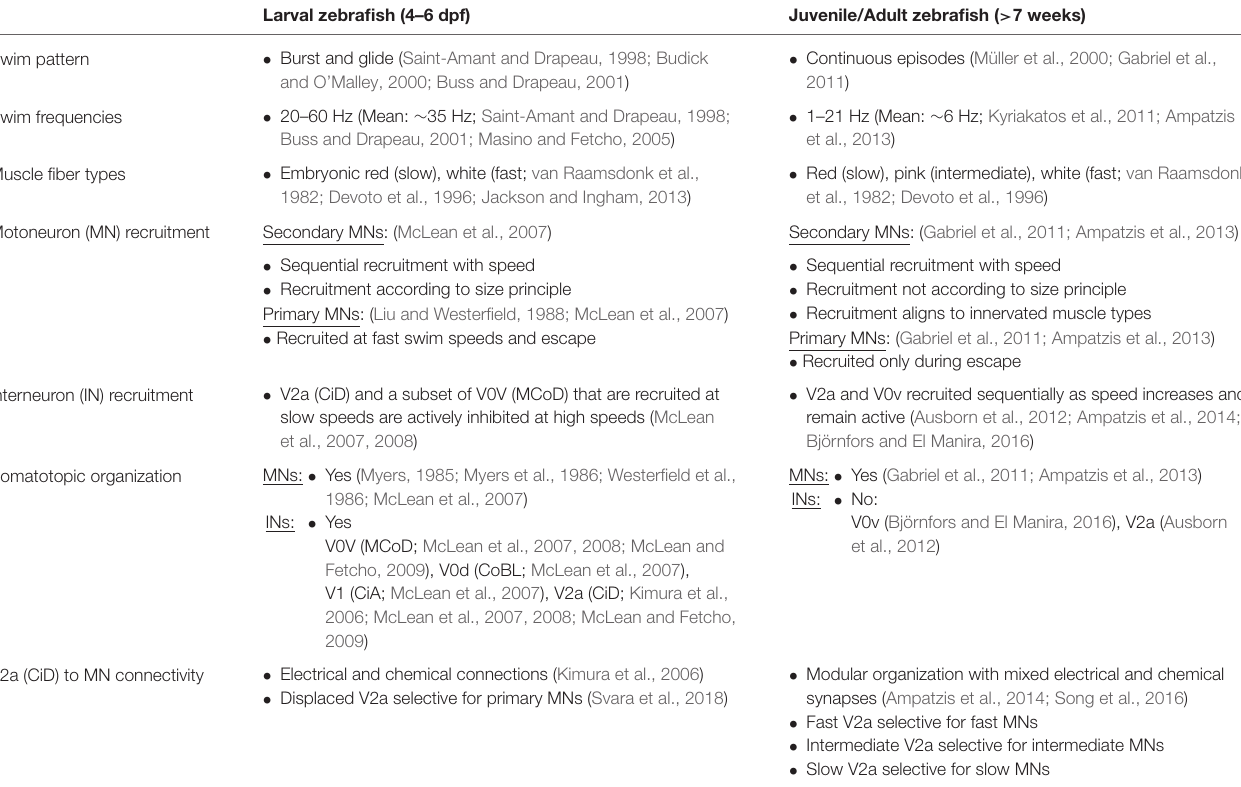
TABLE 1 | A comparison of the swim pattern, muscle properties and swim network organization of the larval and juvenile/adult zebrafish. Larval zebrafish (4–6